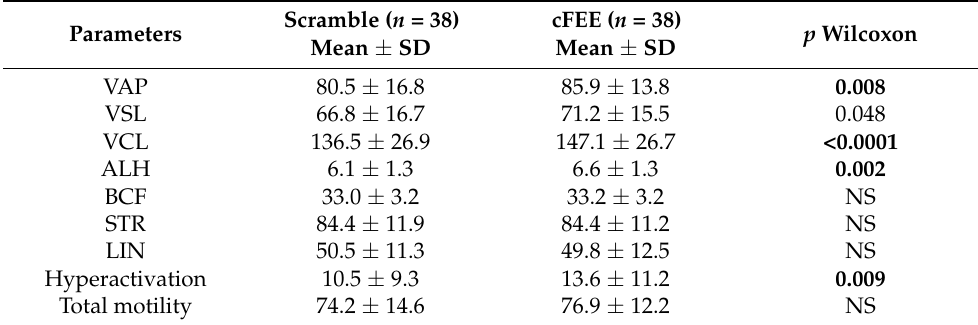
Table 1. cFEE increases sperm movement